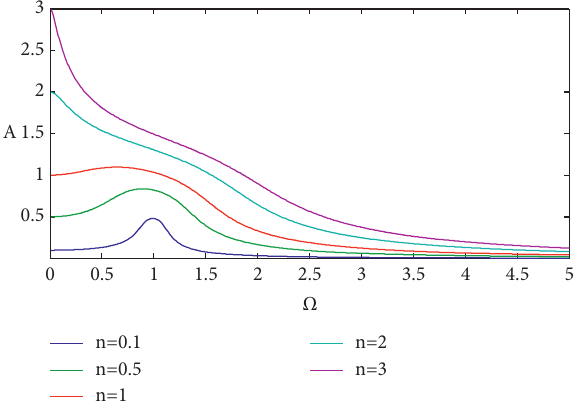
Figure 6: Amplitude-frequency ratio diagram for different n